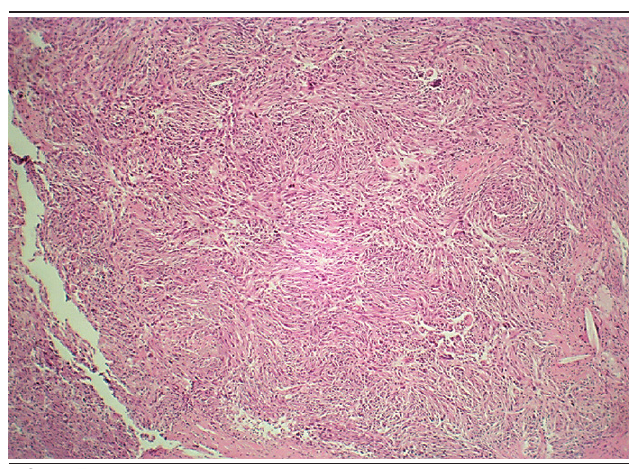
FIguRE 7 − FDCS Whorling bundles and fascicles of tumor cells are admixed with adjacent lymphoid infiltrates. FDCS: follicular dendritic cell